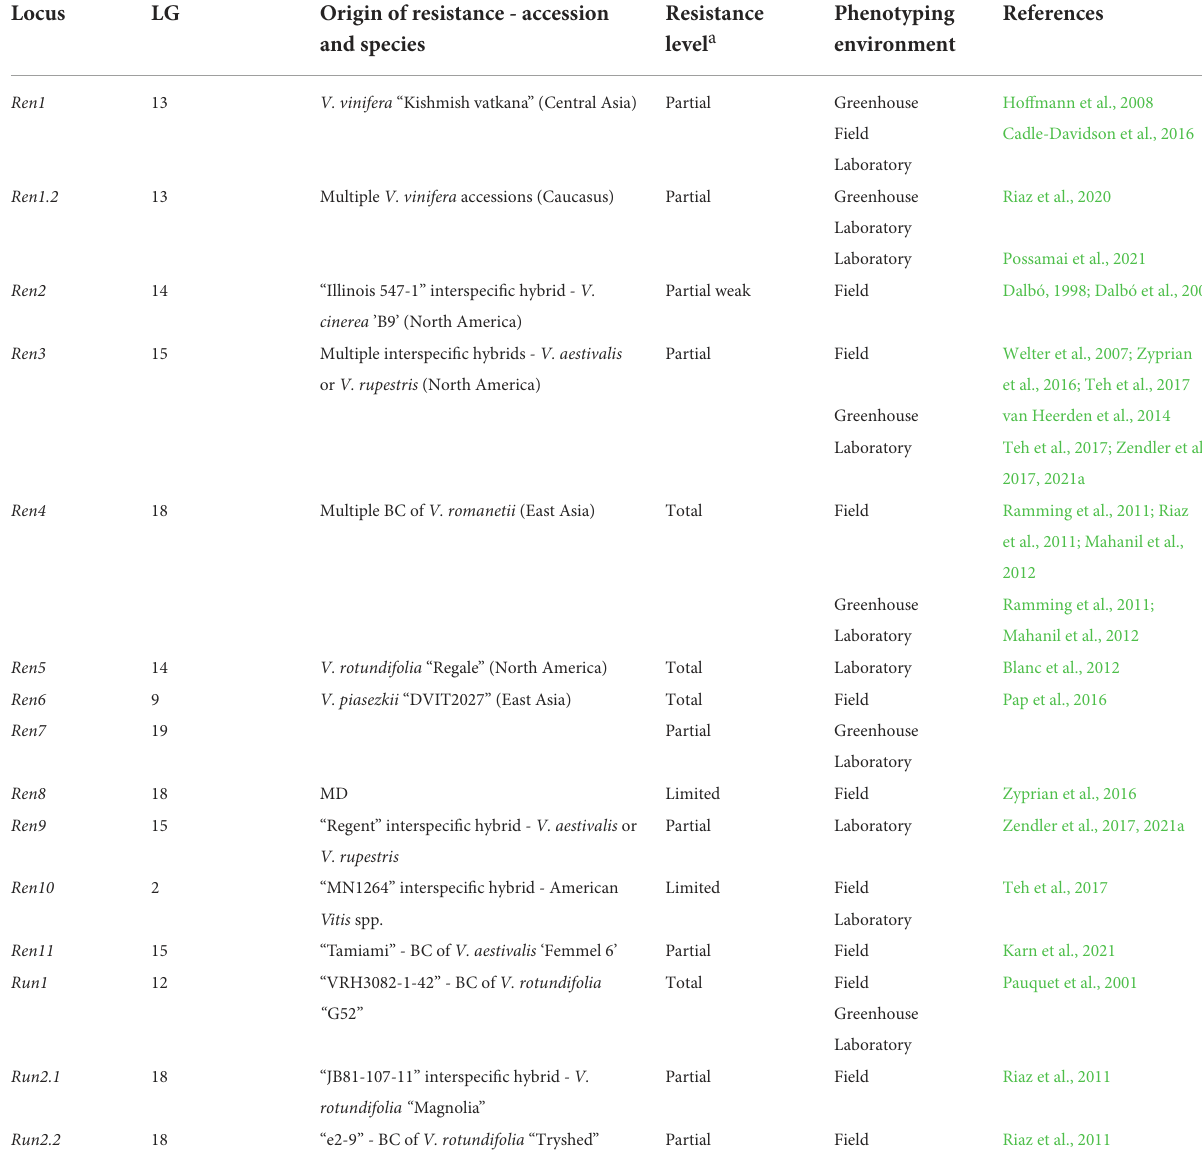
TABLE 2 Loci of resistance to E. necator ( Ren and Run ) identified in grapevine. Resistance loci are listed with information about the grapevine accession/species of origin, the putative level of resistance associated with the locus and the environment of phenotyping utilized in the mapping